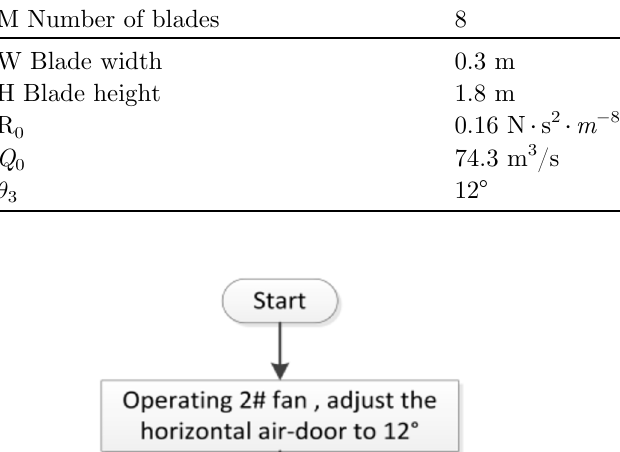
Fig. 10. Angle changes of four rotary blade